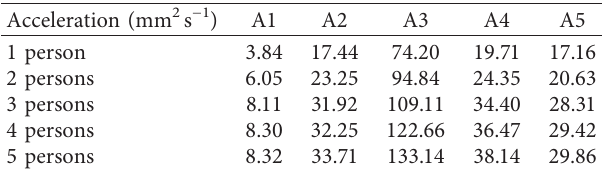
Figure 10: Acceleration distributions under single-person jumping tests: (a) peak acceleration distributions; (b) peak 1s RMS acceleration distributions. Table 4: The peak accelerations due to multiperson jumping tests. Table 5: Damping ratio obtained from multiperson jumping